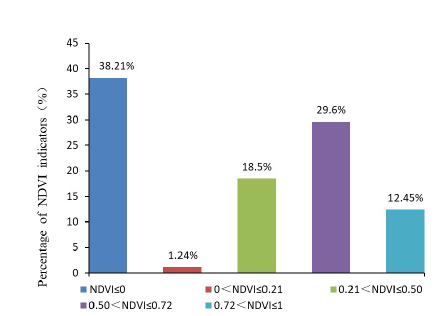
Figure 4. Proportion of NDVI indicators in Lijiang River Basin